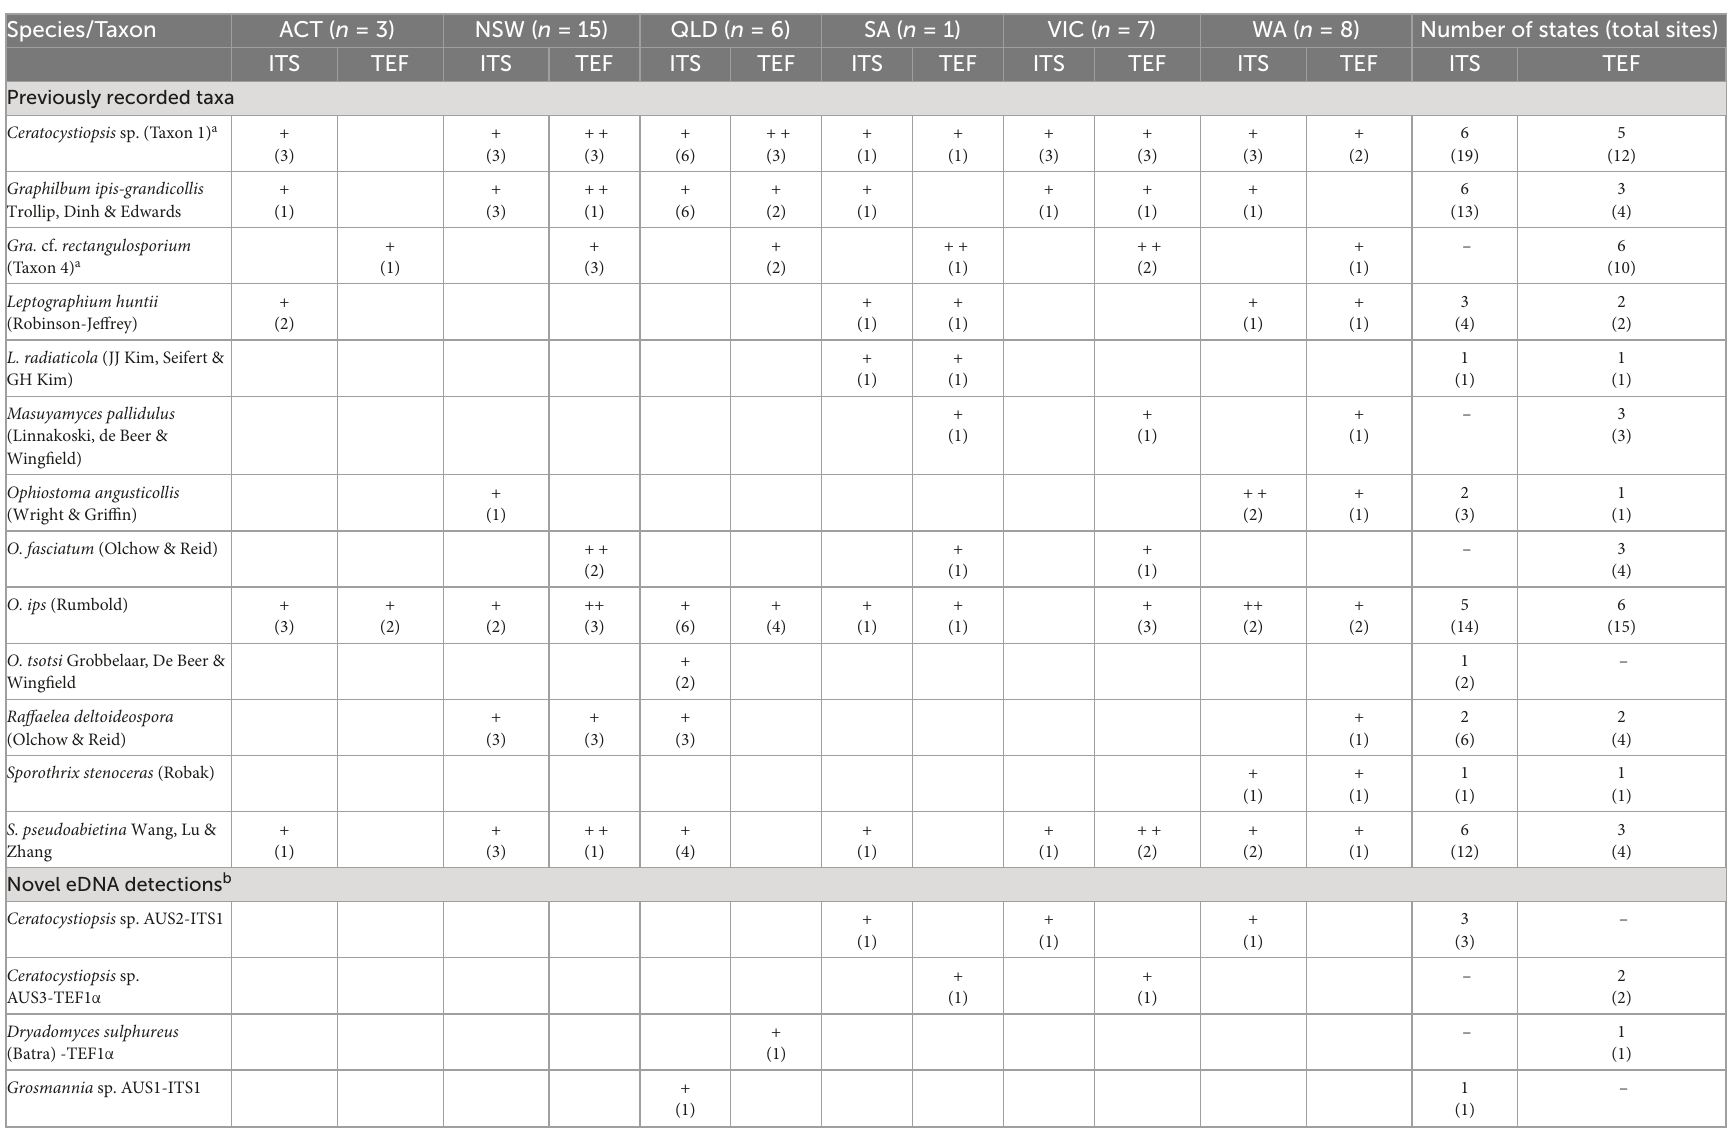
TABLE 3 Detections of Ophiostomatales taxa from surveillance traps collected across mainland Australia.